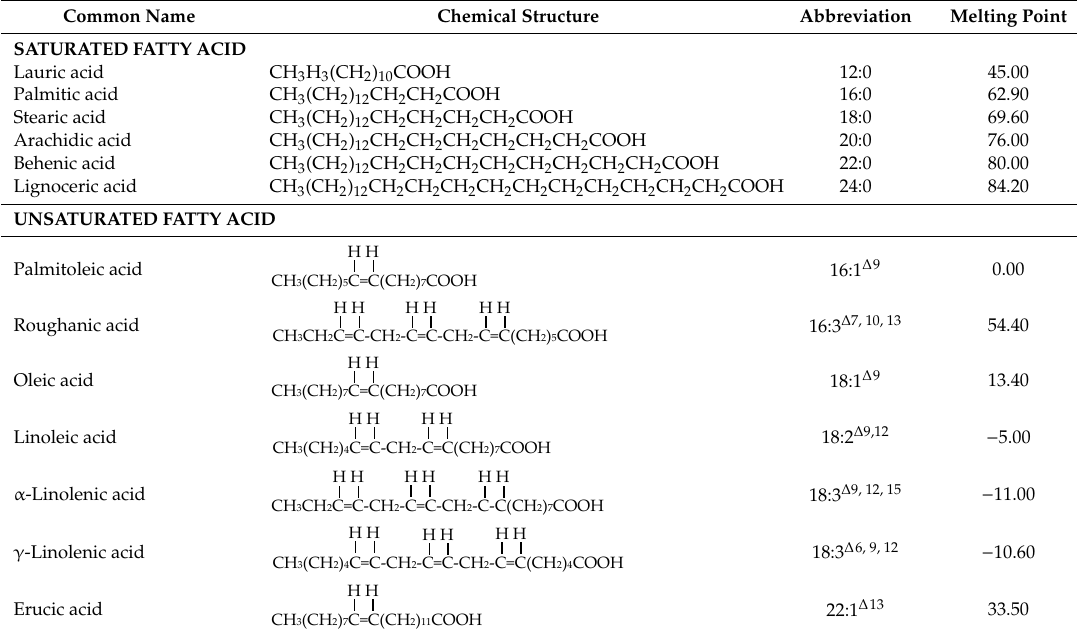
Table 1. Common saturated and unsaturated fatty acids found in membrane and storage lipids of plants.